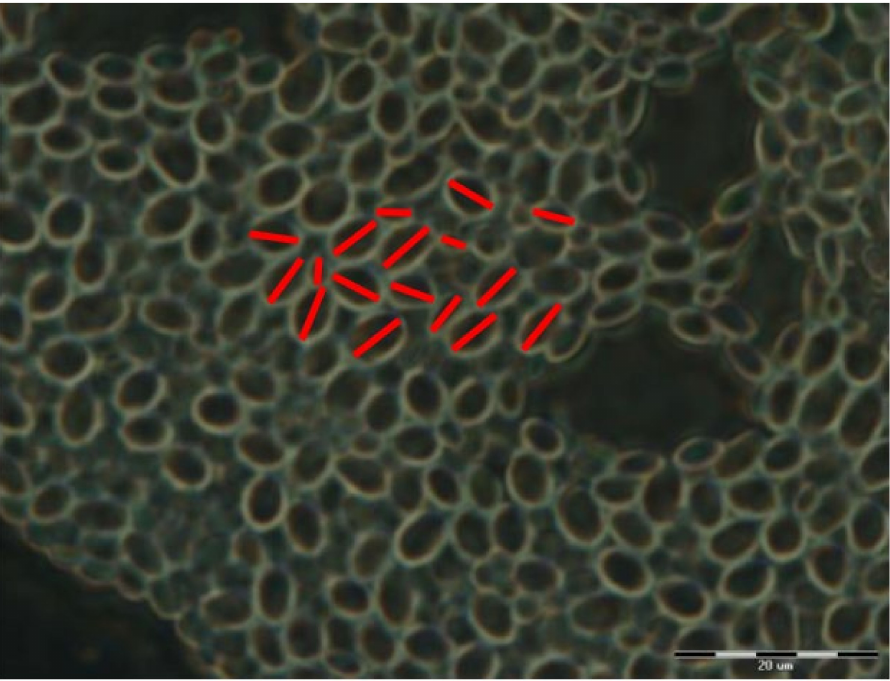
Figure 4. Sc cells deposited on the surface of a substrate. Similar images were used for processing. Red lines depict the approach used for measuring cell size.